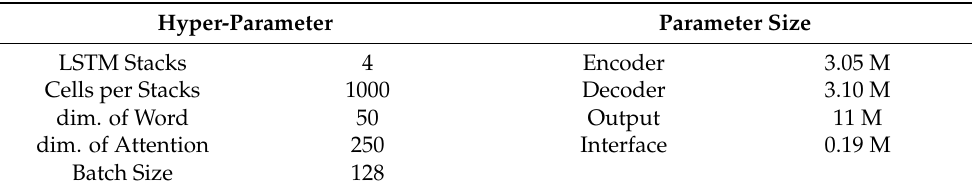
dim. of Attention 250 Batch